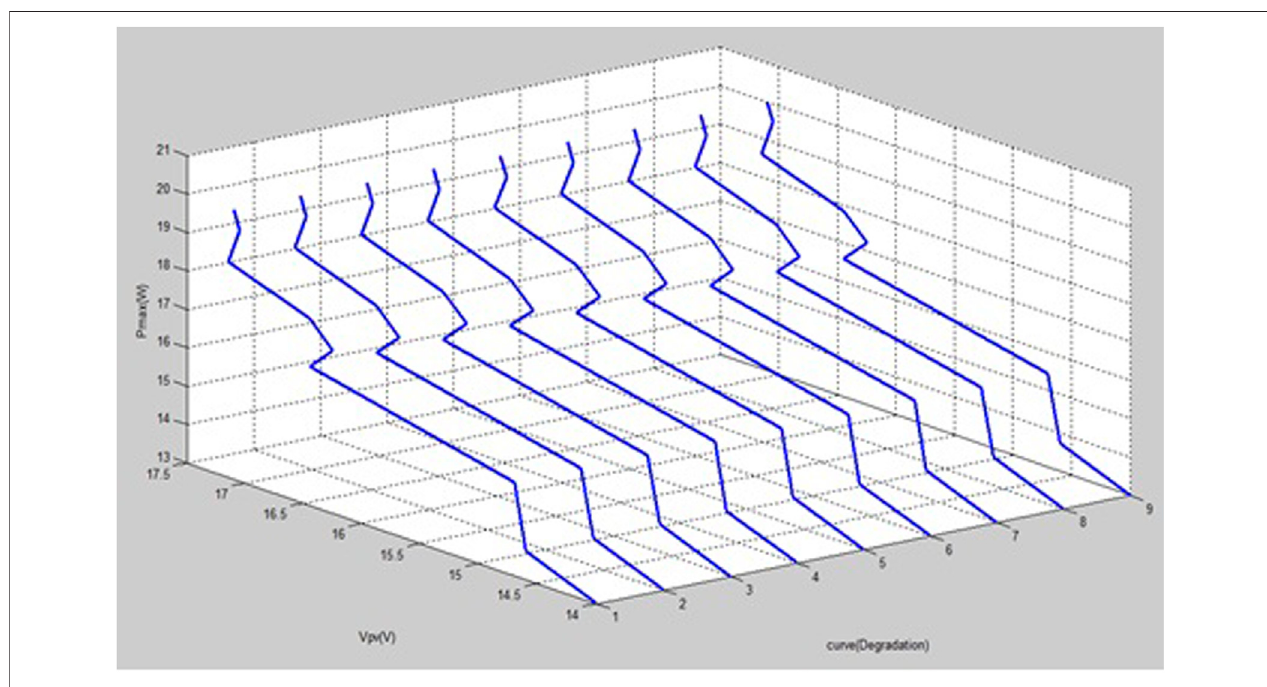
FIGURE 13 | Maximum power against voltage variation in 3D.